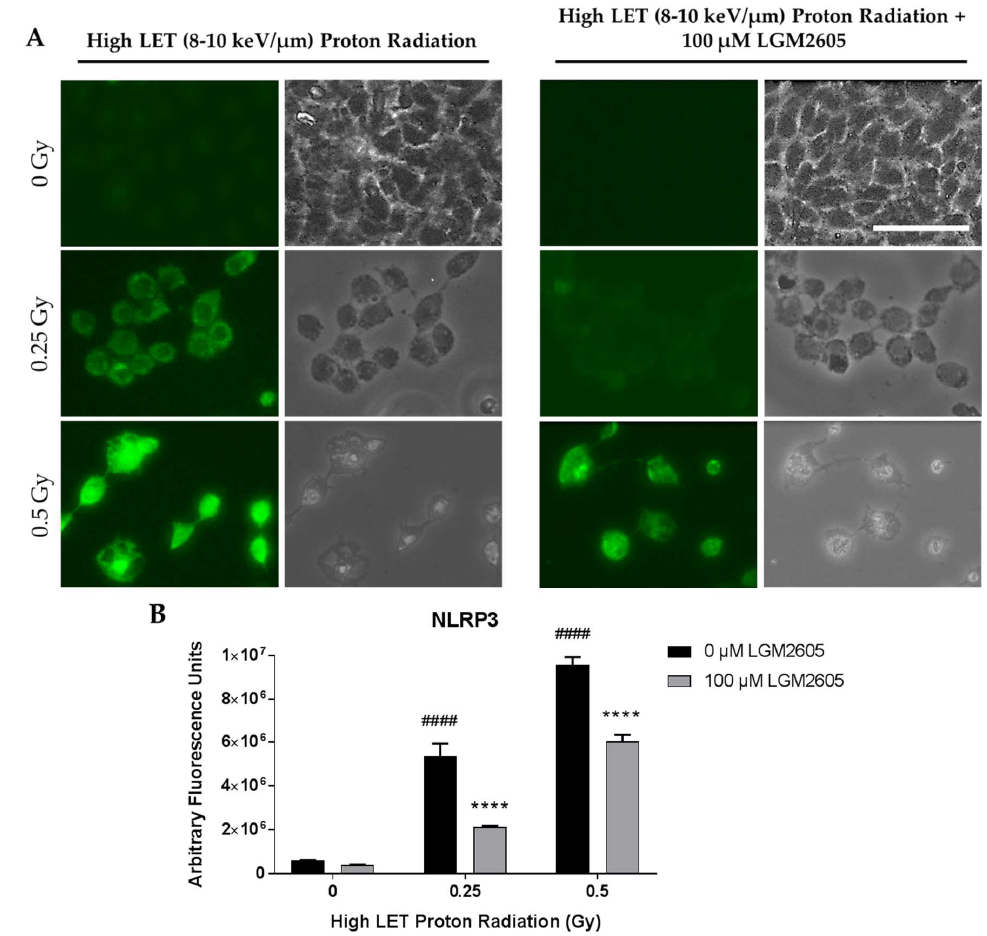
Figure 6. Evaluation of LGM2605 inhibition of NLRP3 activation in in vitro lung vascular networks (flow-adapted endothelial cells) exposed to high LET proton radiation. FAECs were exposed to 0 Gy, 0.25 Gy, or 0.5 Gy high LET (8–10 keV/ µ m) proton radiation and treated with 0 µ M or 100 µ M LGM2605 30 min following radiation exposure. Cells were harvested 24 h post radiation exposure and evaluated for NLRP3 inflammasome activation. Fluorescent images of FAECs exposed to LGM2605 (0 µ M or 100 µ M) 30 min following radiation exposure and harvested at 24 h radiation exposure and incubated with anti-NLRP3 antibody (R&D Systems, Minneapolis, MN, USA). Scale bar = 20 µ m ( A ); graphed representation of the data imaged for each condition ( B ). Data are presented as mean ± SEM. # shown in figures indicate significant differences from FAECs exposed to 0 Gy high LET proton radiation and treated with 0 µ M LGM2605 (#### p < 0.0001). Asterisks shown in figures indicate significant differences from FAECs exposed to 0.25 Gy or 0.5 Gy high LET proton radiation and treated with 0 µ M LGM2605, respectively (**** p <